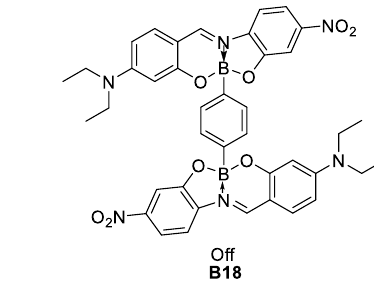
Figure 15. Molecular switch with NLO properties.